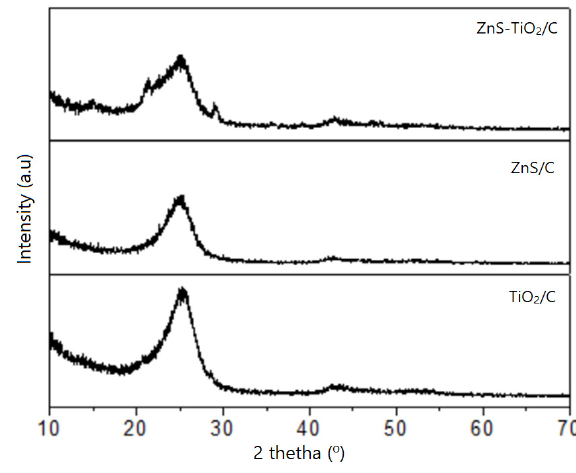
/C, and ZnS-TiO 2